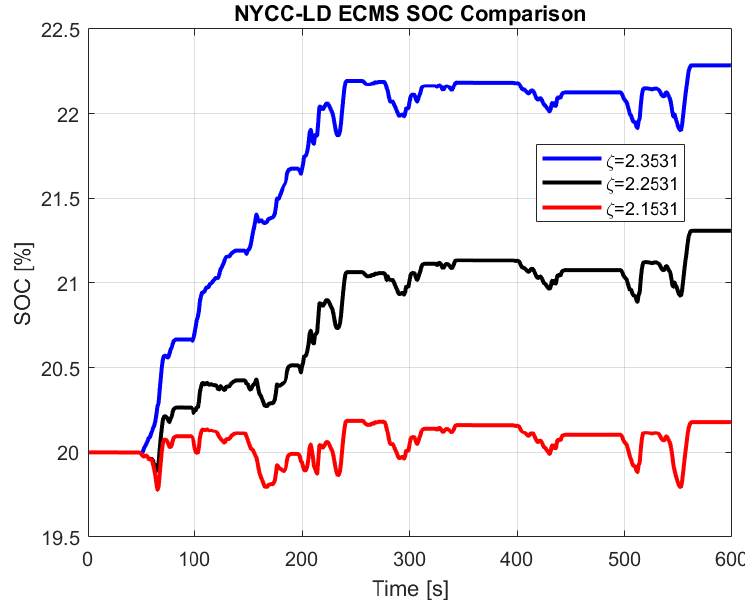
Figure 2. ECMS equivalence factor comparison for